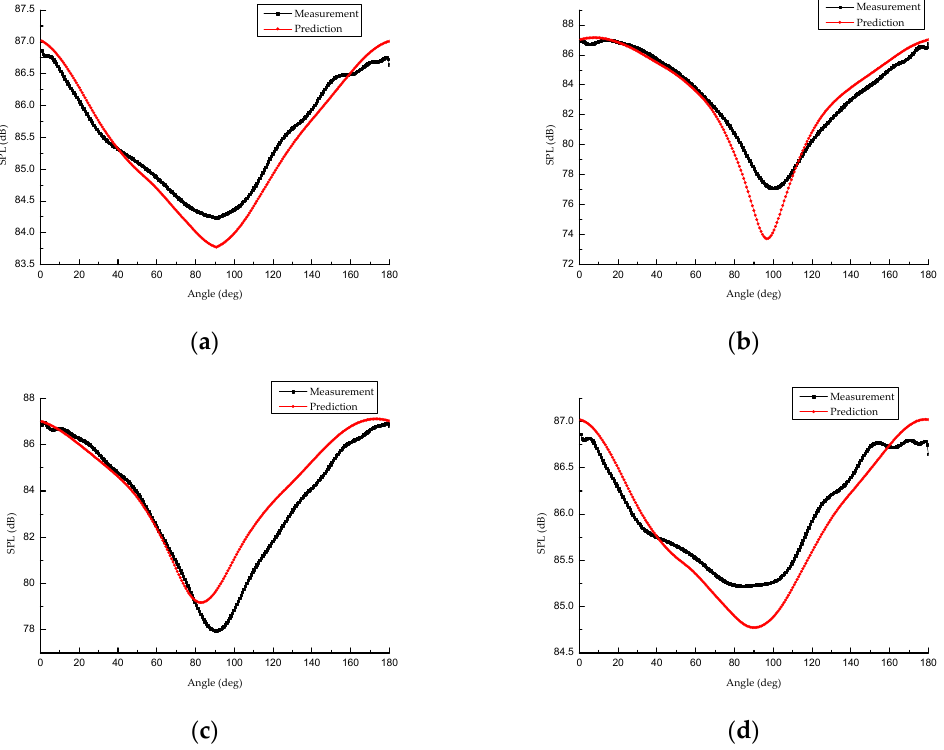
Figure 3. Sound pressure level (SPL) over the angle range 0 – 180° at four microphone locations: ( a ) No.1 installation hole; ( b ) No.2 installation hole; ( c ) No.3 installation hole; ( d ) No.4 installation hole.